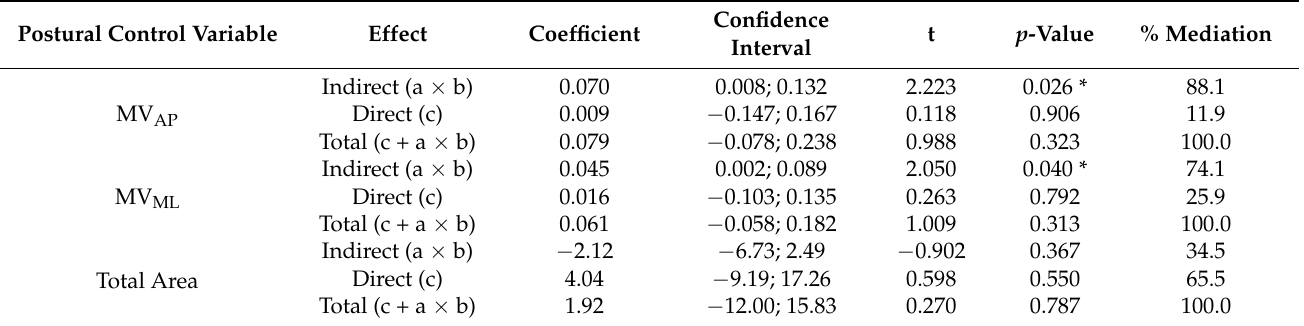
Table 3. Approximate mediating role of the variable (VAR_CE) in the relationship between proprio- ception and the variables measuring postural control with eyes